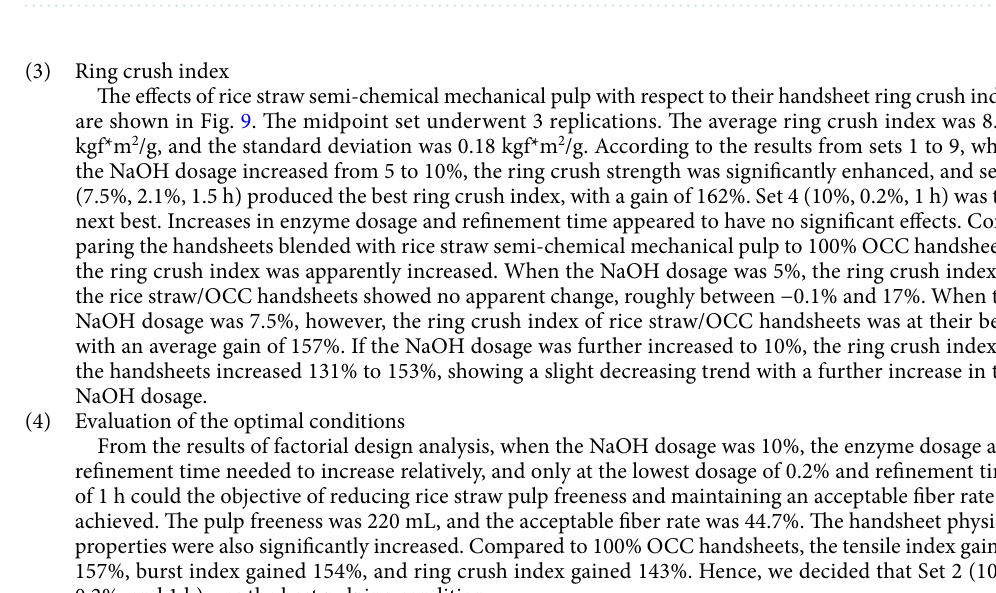
Figure 9. The effects of rice straw semi-chemical mechanical pulp on the ring crush index of